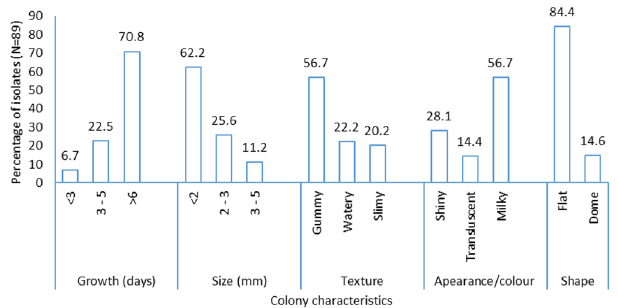
Figure 1. Morpho-physiological description of Bambara groundnut isolates (N = 89) from various locations in Ghana, Mali and South